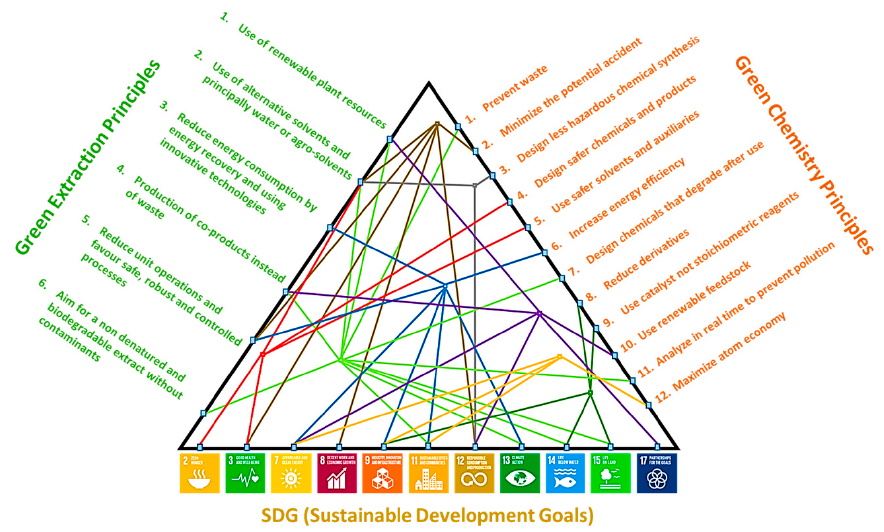
Figure 8. Figure 8. Correlation between SDG related to 2-MeOx and Green Chemistry and Green Extraction principles.